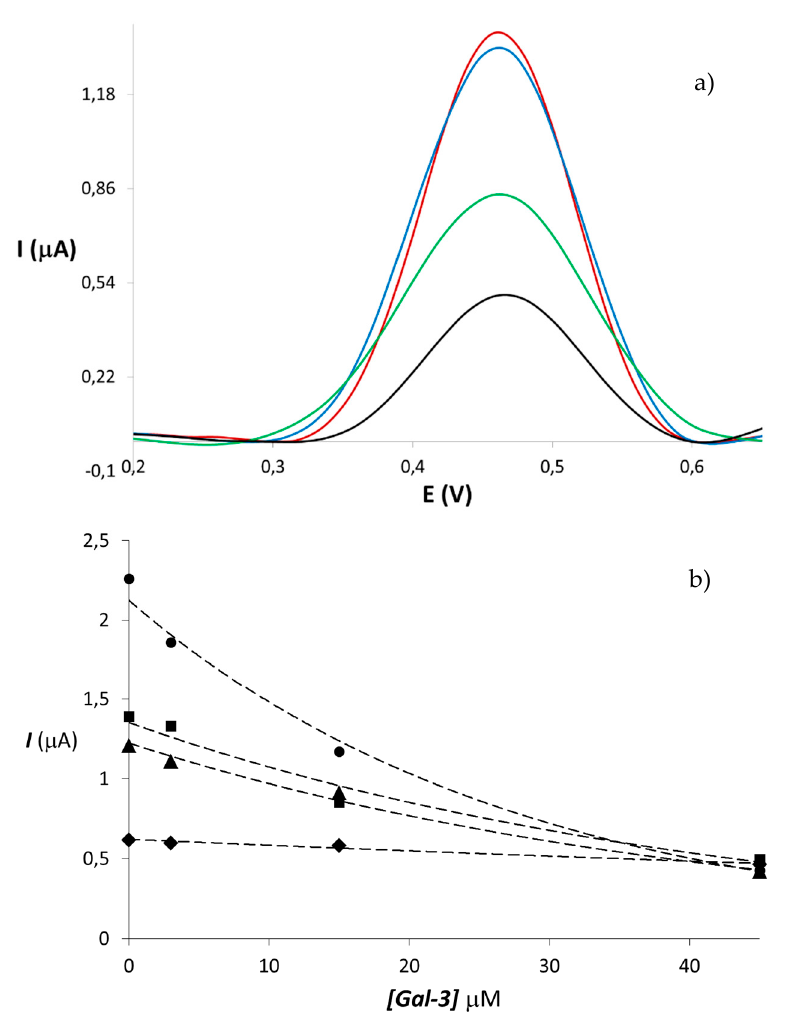
Figure 7. ( a ) Di ff erential pulse voltammograms for compound 13 (12.5 µ M) in the presence of increasing amounts of Gal-3 (0 µ M, red; 3 µ M, blue; 15 µ M, 45 µ M,) in 10 mM phosphate bu ff er at pH 7.2 with 20 NaCl. A decrease in the peak current was observed as the Gal-3 concentration increased. ( b ) Variation of the peak current intensity (DPV) of compounds 18 (50 µ M, rhombs), 12 (25 µ M, triangles), 13 (12.5 µ M, squares), and 14 (6.25 µ M, circles) in the presence of increasing amounts of Gal-3 (dashed lines represent the exponential fits).